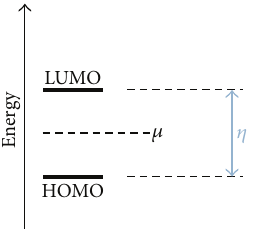
Figure 3: Representation of chemical potential and molecular hardness and its relationship with